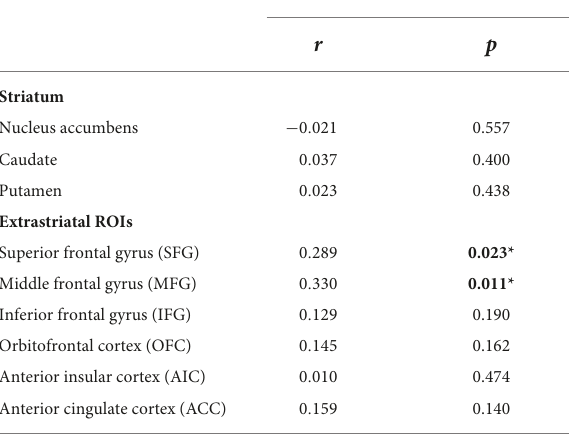
TABLE 3 Semi-partial correlations of ROI D2/3R availability measured as [ 11 C]-raclopride BP ND and self-reported autonomous motivation.